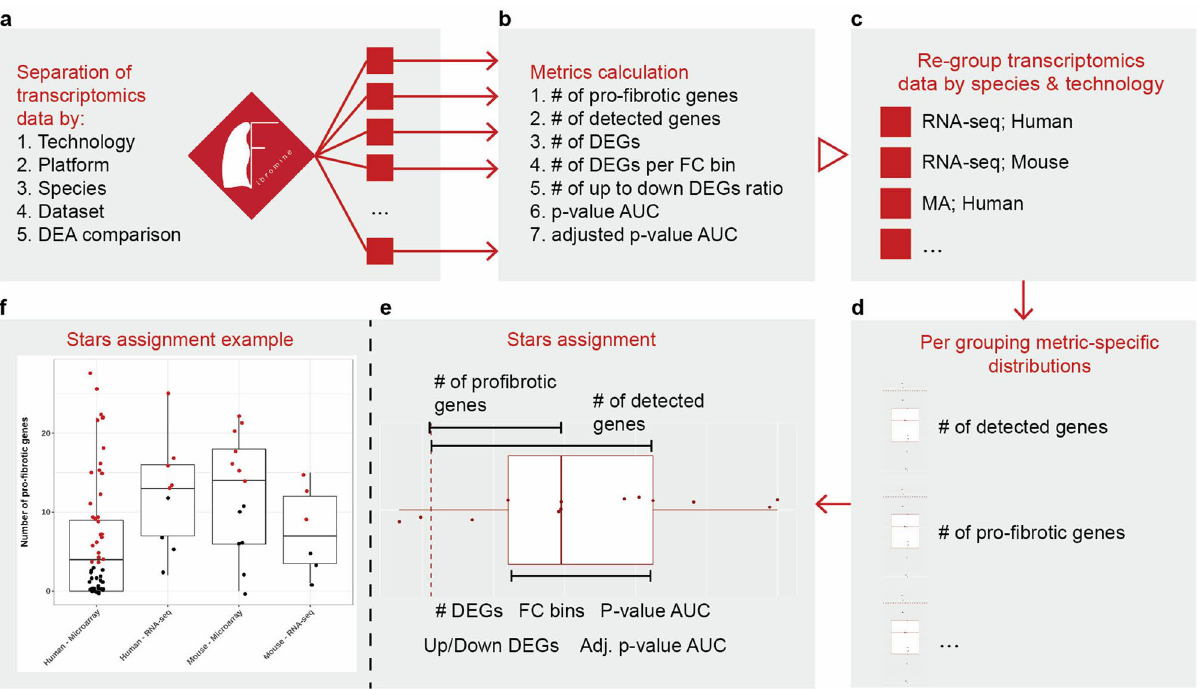
Figure 2. Fibromine transcriptomic datasets benchmarking workflow. In order to reveal the most homogeneous transcriptomic datasets of Fibromine, seven metrics were calculated (b) post to data separation (a) . Subsequently, transcriptomic data were grouped per species and technology (c) and seven metric-specific distributions were shaped for each of the dataset groups (d) . Finally, every dataset/DEA comparison was evaluated relative to the rest of its grouping and assigned a star if the calculated criterion value lied within a pre- specified interval of the respective distribution (e) . Each dataset received 7 stars to the maximum and none to the minimum. Datasets with many stars are more closely related to each other than to the rest of the group. (f) A real example of stars assignment: red dots are datasets/DEA comparisons assigned a star for the Number of pro- fibrotic genes criterion. Datasets investigating exclusively non-protein coding genes were processed separately using the same workflow. Boxplots depict the interquartile range and median of the data; whiskers extend no longer than 1.5 times the length of the boxplot. DEGs: differentially expressed genes, FC: fold change, AUC: area under the curve. Figure was created using https:// ggplo t2. tidyv erse. org/ v3.5.5 and https:// www. google. com/ slides/